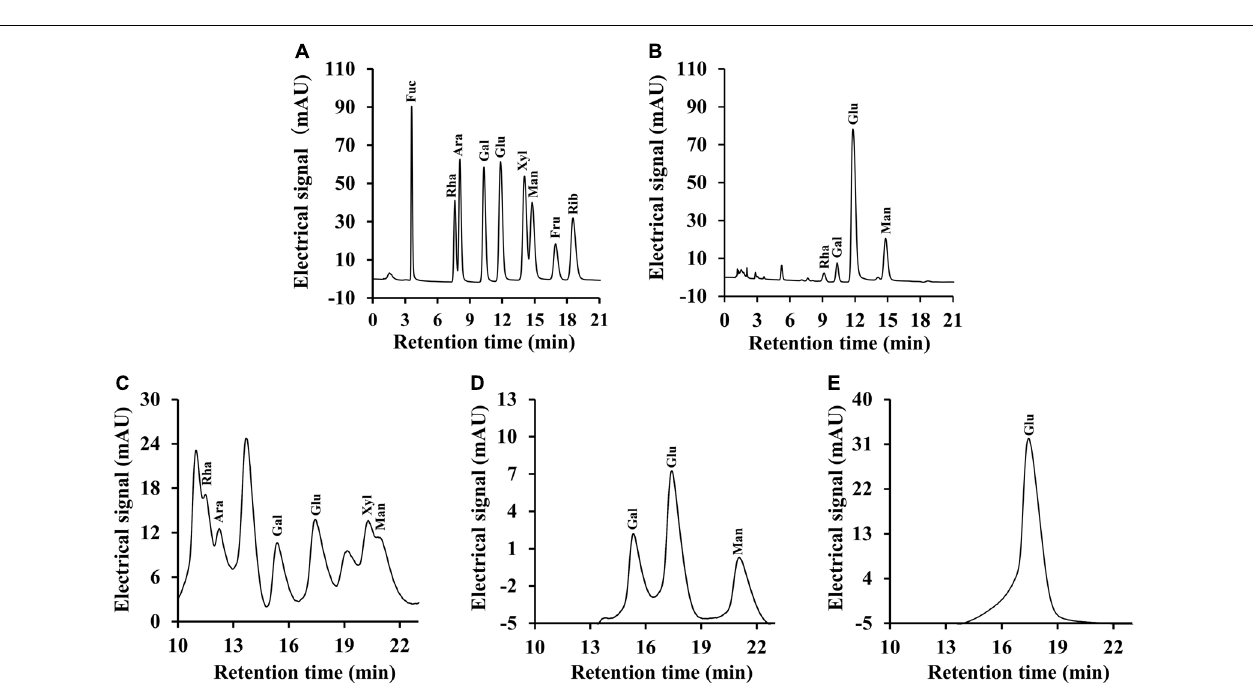
FIGURE 3 | The UV spectra and FT-IR spectra of CSFP, CSFP1- β , and CSFP2- α . (A–C) The UV spectra, and (D–F) the FT-IR spectra.